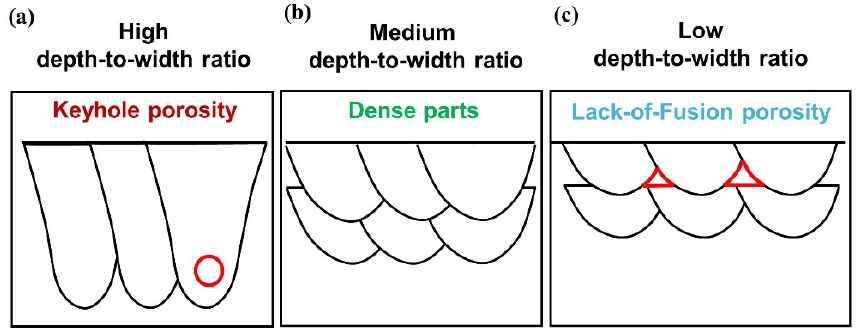
Figure 11. Diagrammatic sketch of the formation mechanism of defects on the: ( a ) high depth-to- width ratio; ( b ) medium depth-to-width ratio; ( c ) low depth-to-width ratio.